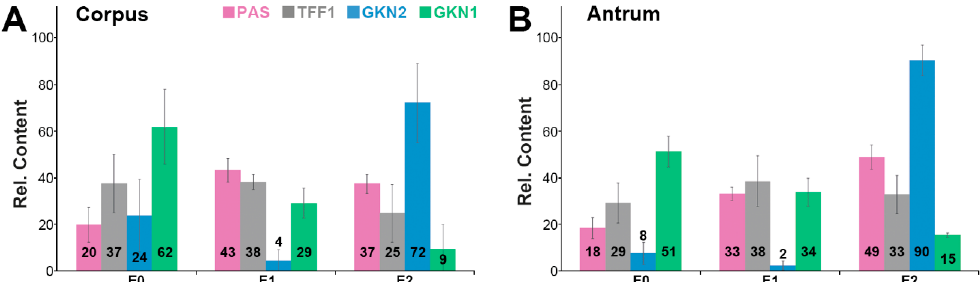
Figure 2. Stepwise extraction of three different human gastric ( A ) corpus and three different ( B ) antrum specimens respectively, and analysis of the extracts E0, E1, and E2. Shown are the relative contents of TFF1 (grey), GKN2 (blue), and GKN1 (green) respectively, as determined by Western blot analysis under reducing conditions and semi-quantitative analysis of the typical monomeric band intensities. For comparison, the mucin content was determined by PAS staining (dot blot;